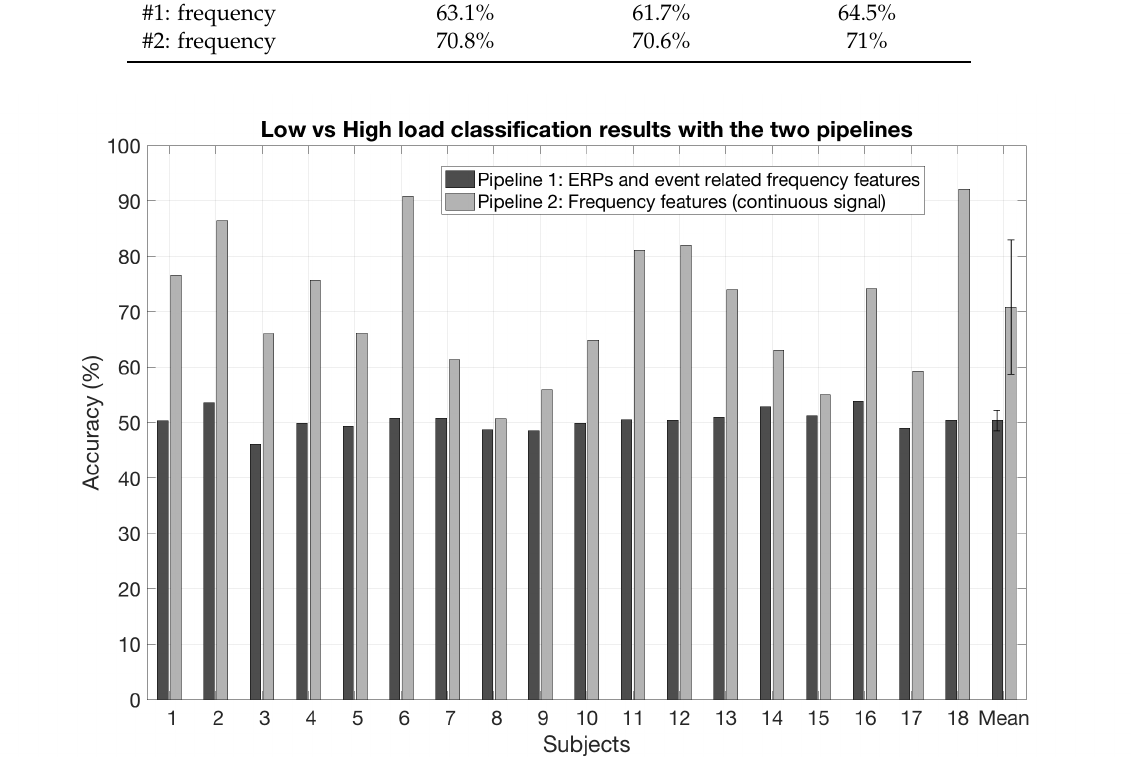
Figure 5. Single-trial classification results with the two pipelines for the 18